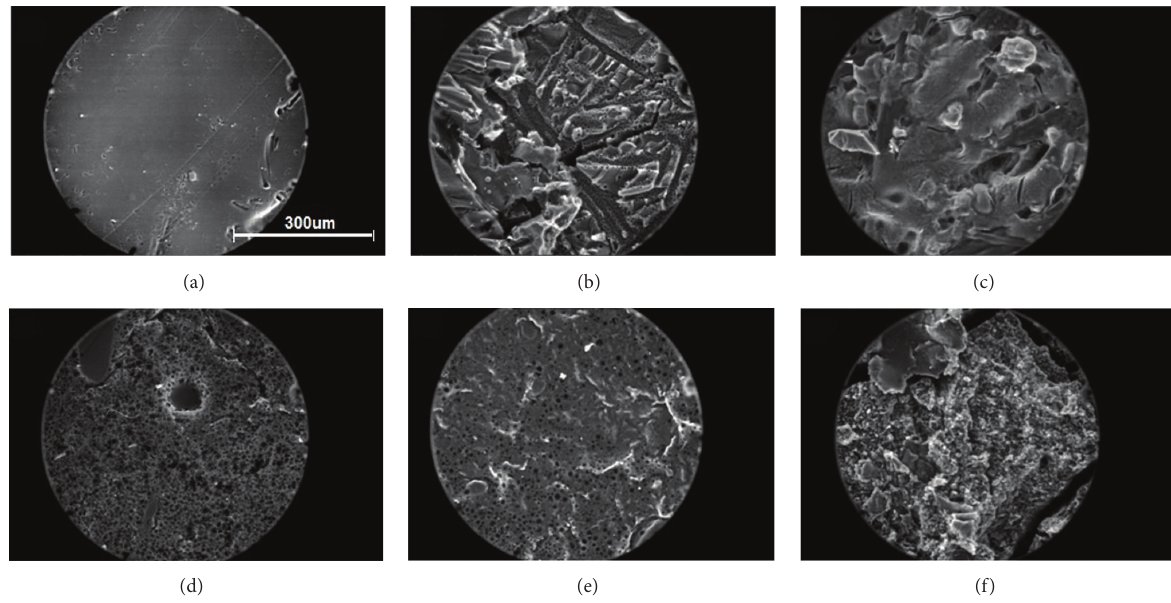
Figure 3: The SEM surface images (500x magnification) of treated membranes using different extraction solvents: (a) PES membrane without modification and extraction treatment, (b) AEM coated with surface on membrane 1 after the extraction in chloroform, (c) AEM coated with surface on membrane 2 after the extraction in chloroform, (d) AEM coated with surface on membrane 1 after the extraction in toluene, (e) AEM coated with surface on membrane 2 after the extraction in toluene, and (f) AEM coated with surface on membrane 1 after the extraction in THF.